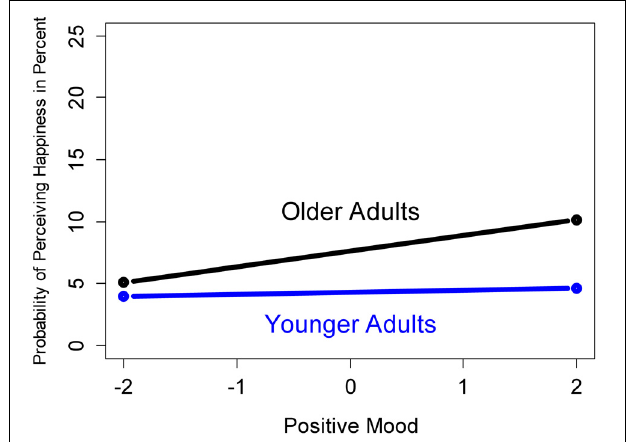
FIGURE 2 | Predicted probability of perceiving an additional happy emotional expression in faces for younger and older adults with maximally high (right) vs. maximally low (left) levels of positive mood.